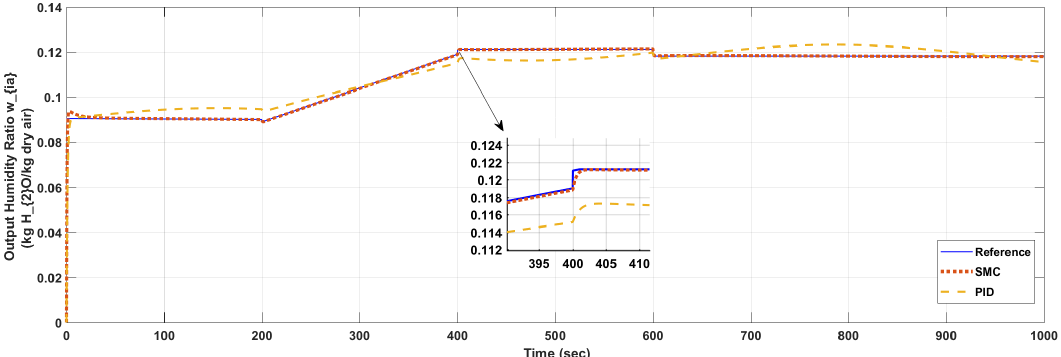
Figure 10. Output humidity response of controllers while tracking combination of sequence of steps and ramp